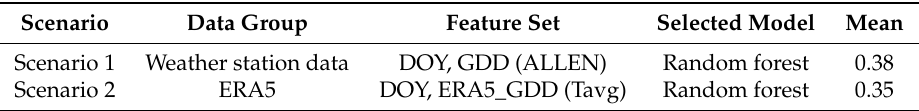
Table 2. The selection of the best performing model for each selected feature combination following the minimum mean combined metric